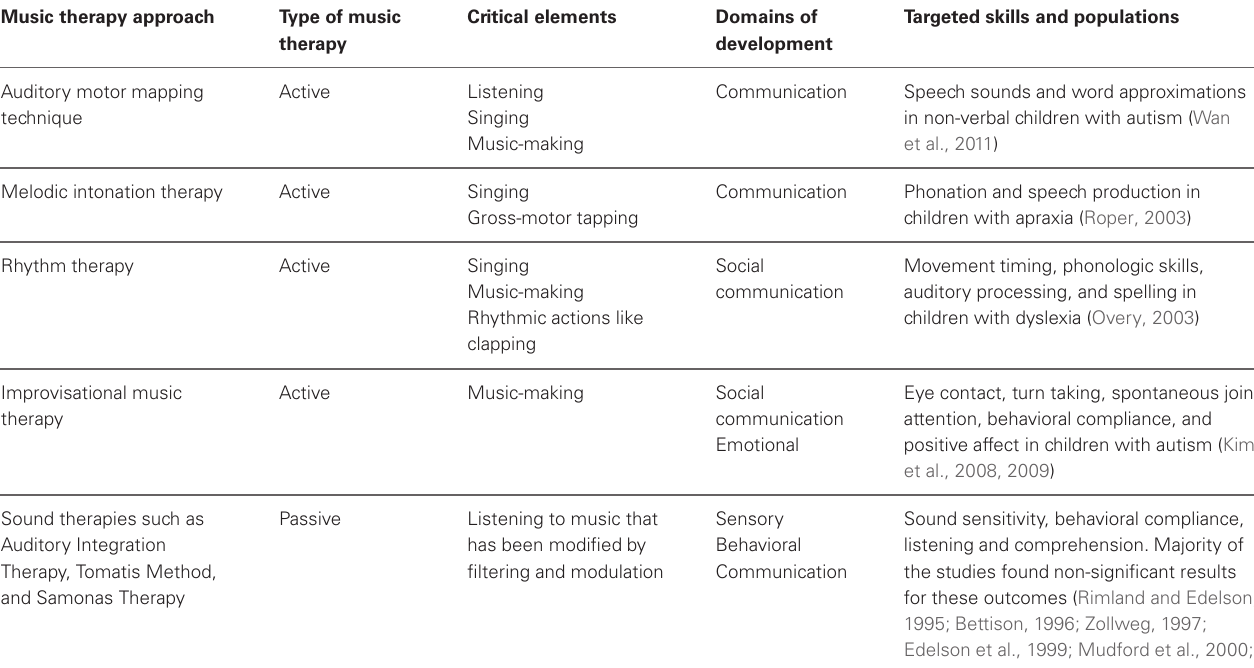
Table 2 | Music therapy approaches: critical elements, domains of development, targeted skills, and